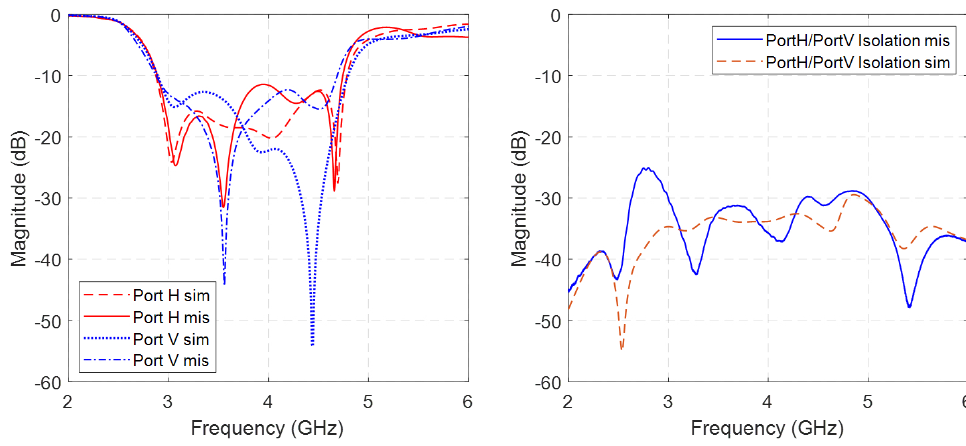
Figure 9. Scaled prototype: simulations vs. measurements. Return loss on the ( left ) and H/V isolation on the ( right